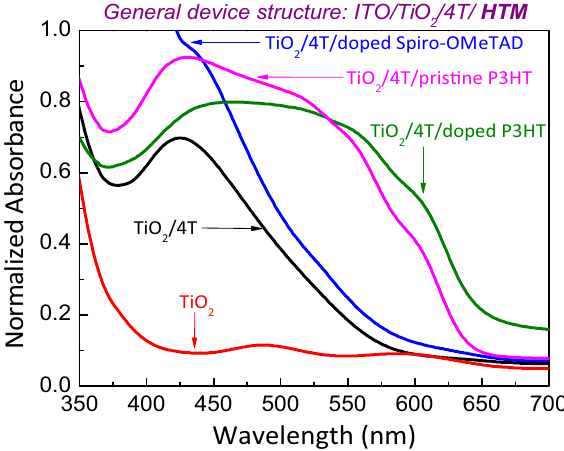
Figure 2. optical absorption spectra of 4T dye treated mesoporous TiO 2 electrode and doped P3HT or doped Spiro-OMeTAD along with the control TiO 2 /4T/P3HT structure and porous TiO 2